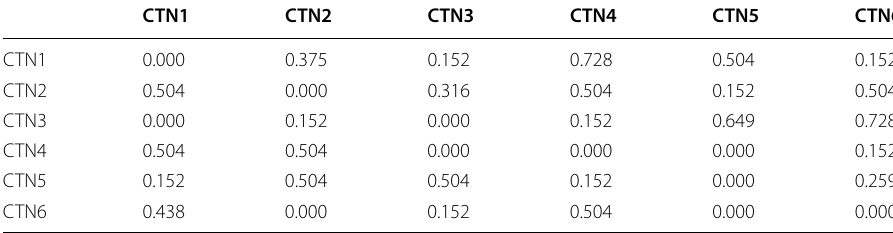
Table 5 Score function values of the criteria for